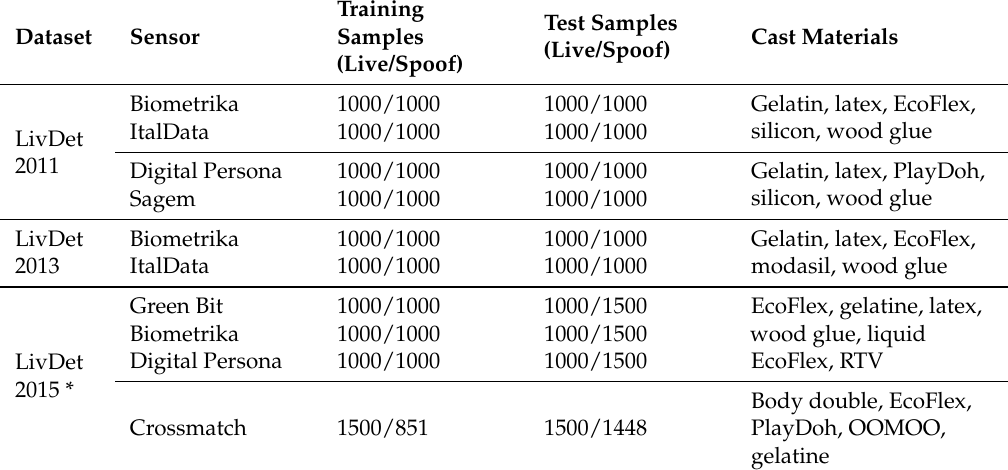
Table 3. Summary of the datasets used in the experiments (2).